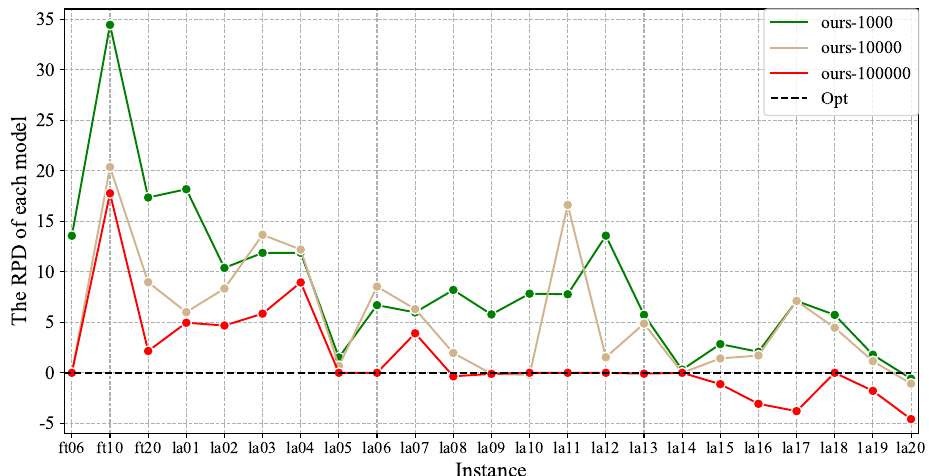
Figure 8. The RPD of each SPP-Transformer on each